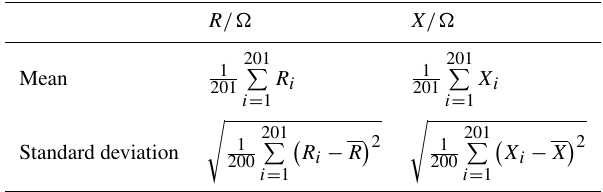
Table 3. Relative uncertainties in the real and imaginary parts of the MUT impedances and the associated frequencies, at a confidence level of 95%.